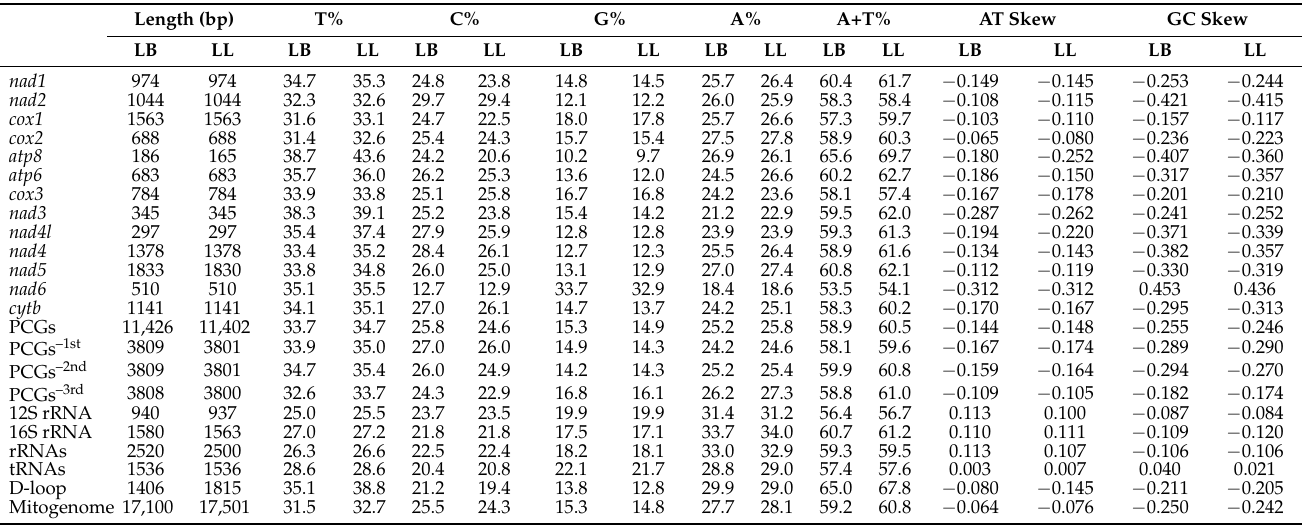
Table 3. Nucleotide composition and skewness of different regions in the mitogenomes of L. boringii (LB) and L. liui